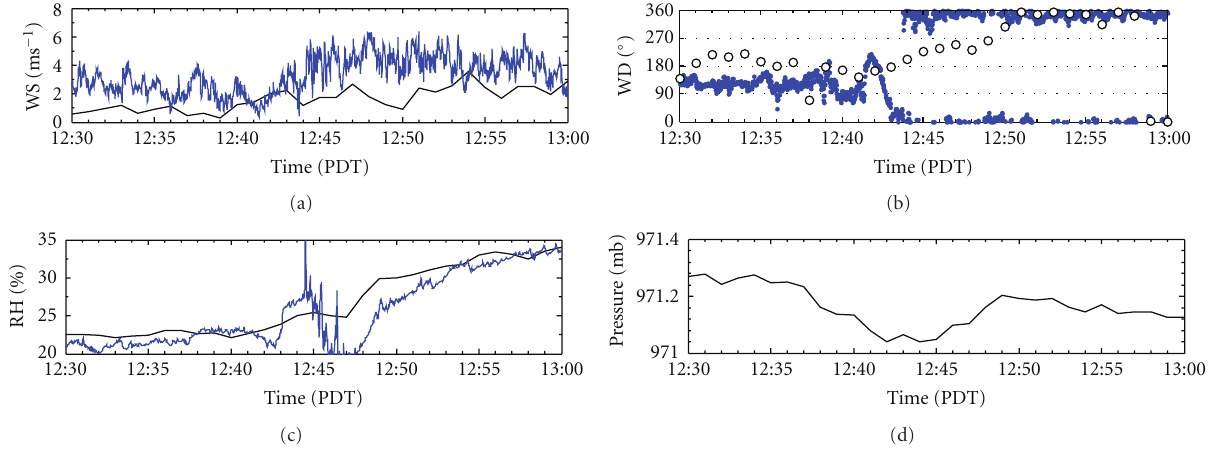
Figure 9: Time series of (a) wind speed, (b) wind direction, (c) relative humidity (RH), and (d) pressure measured at the interior tower and downwind RAWS between 12:30 and 13:00 PDT. The tower data and RAWS data are averaged over 1s and 1min, respectively. The blue represents the interior tower and the black represents the